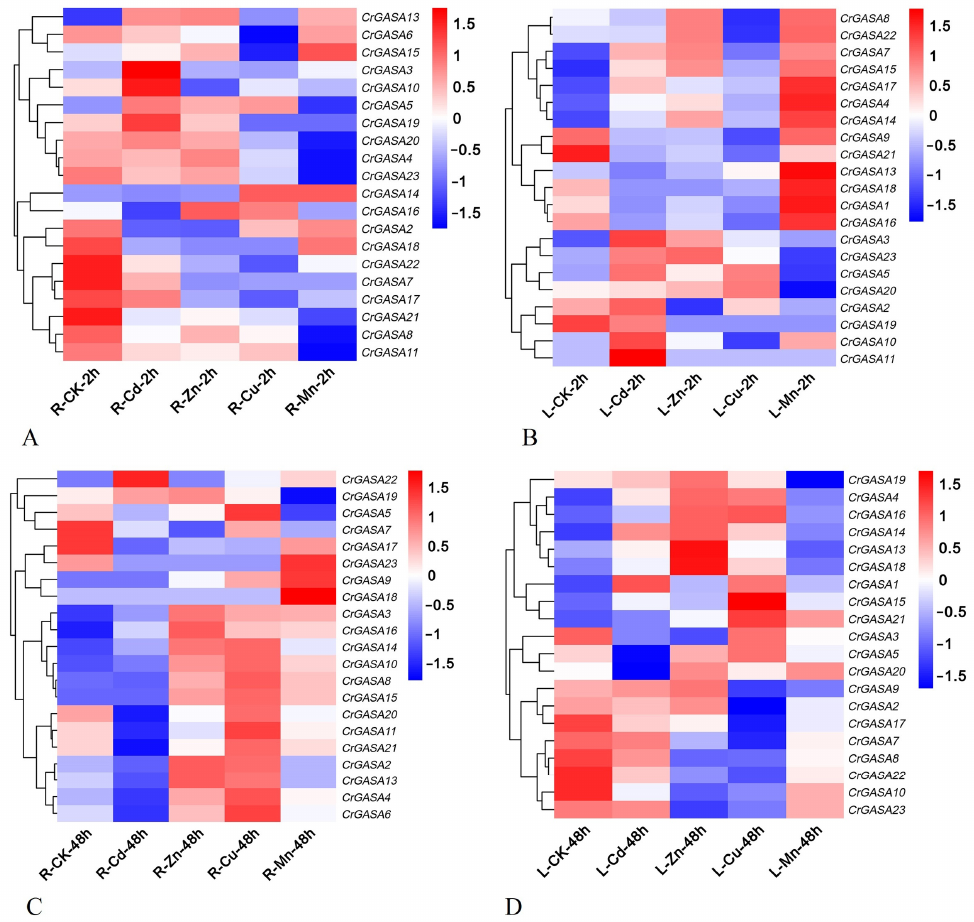
Figure 8. Heatmaps showing the expression levels of the CrGASA s under heavy metal stress, including cadmium (Cd), zinc (Zn), copper (Cu), and manganese (Mn). ( A , B ) The expression differences of CrGASA s in the root (A) and leaf (B) after 2 h heavy metal stress; ( C , D ) the expression differences of CrGASA s in the root ( C ) and leaf ( D ) after 48 h heavy metal stress. CK: control. The expression level of each gene is shown in FPKM (log2). Red denotes high expression levels, and blue denotes low expression levels. Data normalization was performed on the Oebiotech Cloud website (https://cloud.oebiotech.cn/task/detail/heatmap/ (accessed on 1 March 2022)).